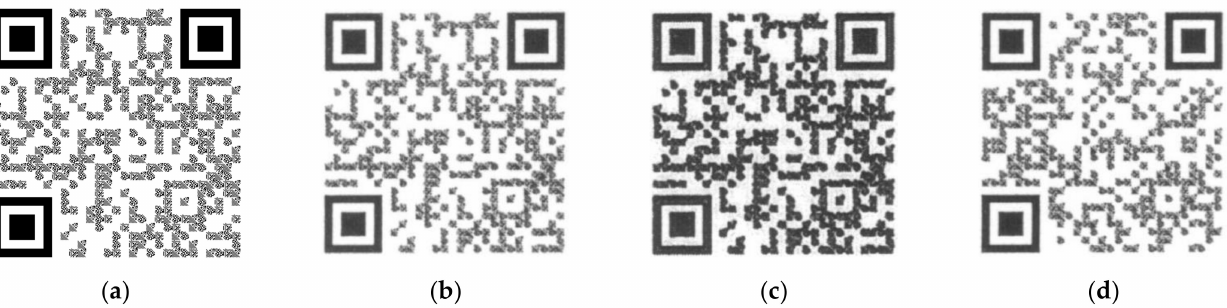
Figure 13. Example tags used to test the prototype system. ( a ) The original image of an authentic tag. ( b ) The scanned image of an authentic tag (printed version of image in ( a )). ( c )The scanned image of a counterfeit tag (cloned version of the authentic tag in ( b )). ( d ) The scanned image of a forged